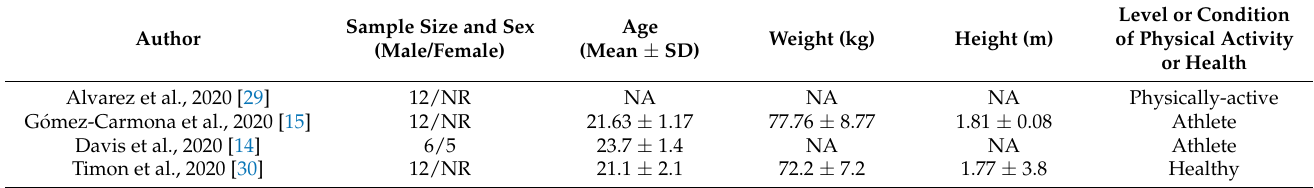
Table 3. Characteristics of the participants of the studies selected for the